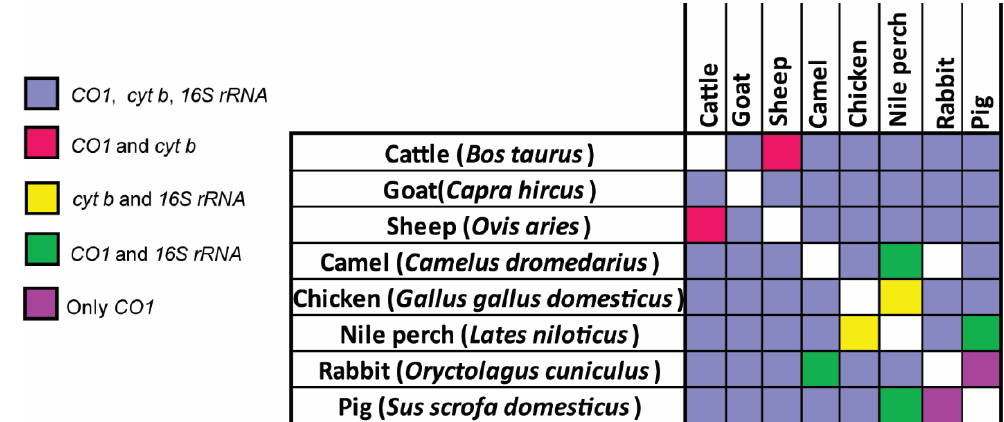
Figure 3. Pairwise discrimination of vertebrate sources of meat by PCR-HRM analysis: Three mitochondrial markers, CO1 , cyt b , and 16S rRNA, were compared. The abilities of these markers to distinguish eight different vertebrate species commonly consumed in Kenyan households were compared and the summary matrix was generated.